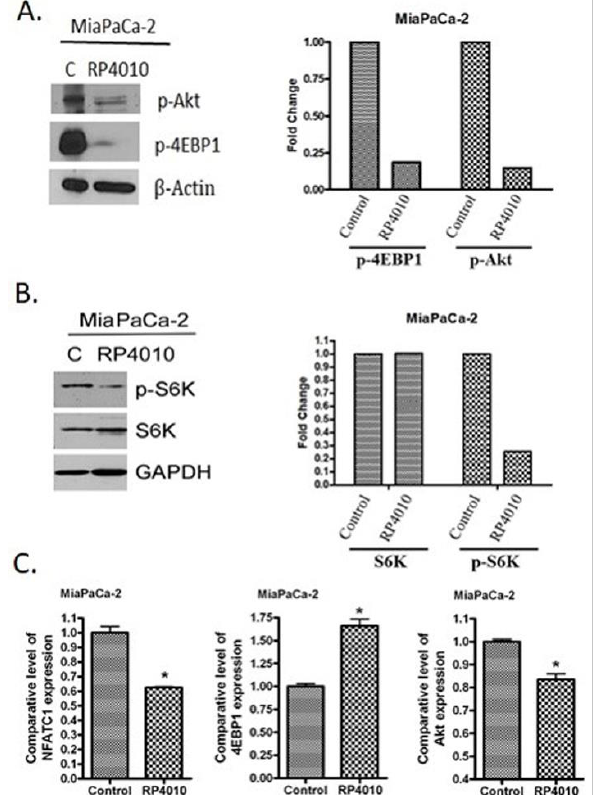
Figure 2. RP4010 inhibited calcium-regulated Akt / mTOR and NFAT signaling. ( A and B ) MiaPaCa-2